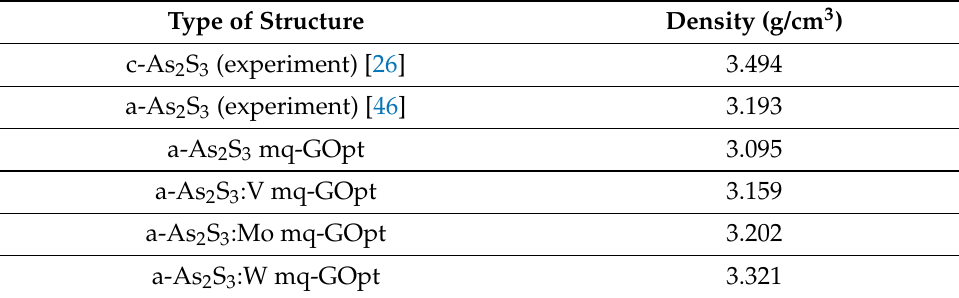
Table 1. Densities of As 2 S 3 and As 2 S 3 :TM structures.